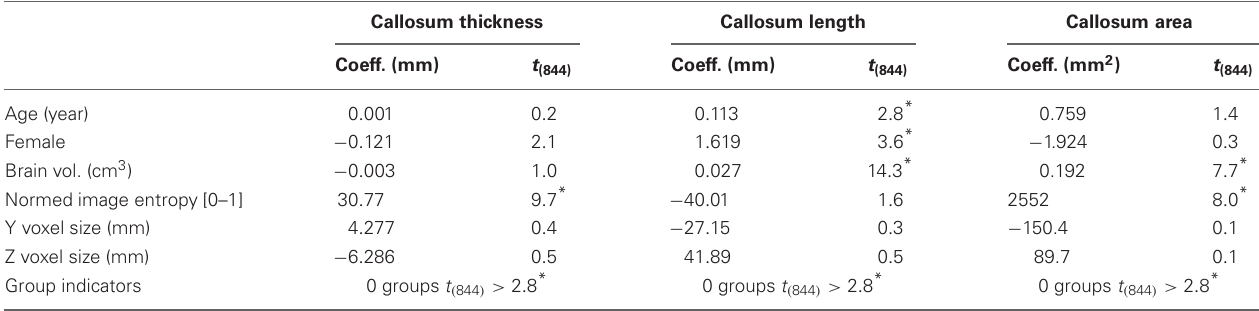
Table 4 | Regression equation coefficients and t -values computed from young, normal FCP data from 14 groups for overall thickness, median length, and area